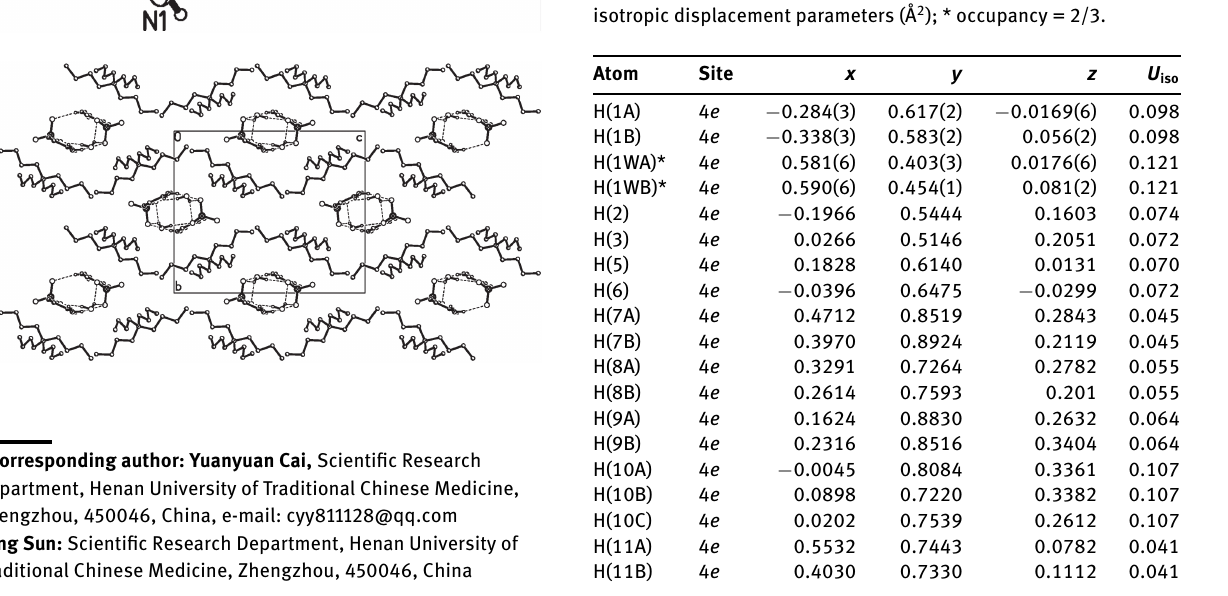
Table 2: Fractional atomic coordinates and isotropic or